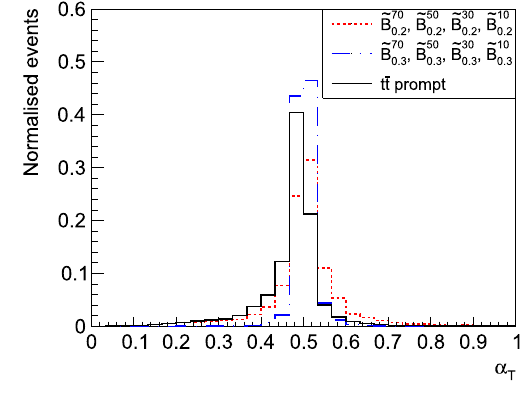
Fig. 21 Transverse momentum of the leading lepton in the ˜ B -like case